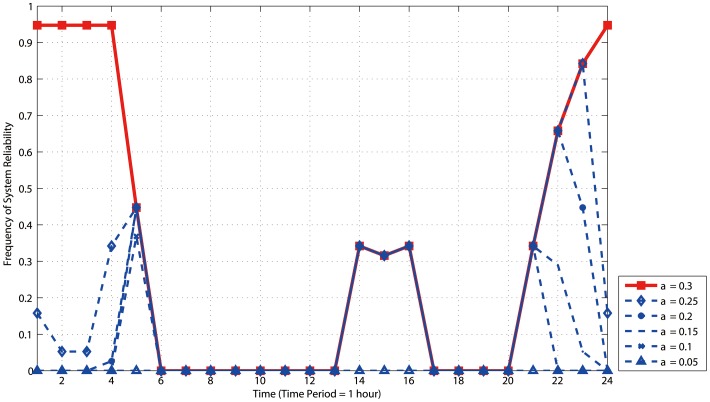
Frequency diagram of the maximum value (Rsys = 1) of system reliability within 24 hours.